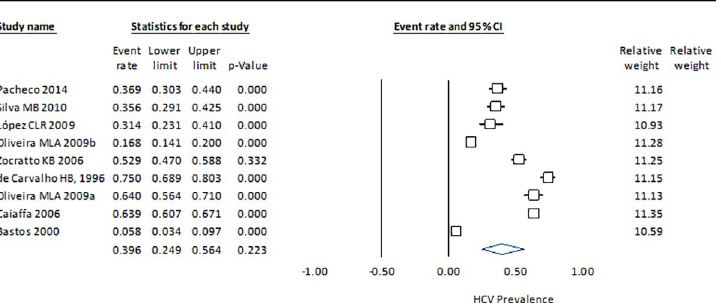
Fig 3. Forrest plot of random effects model to estimate HCV prevalence in IDU population in Brazil.